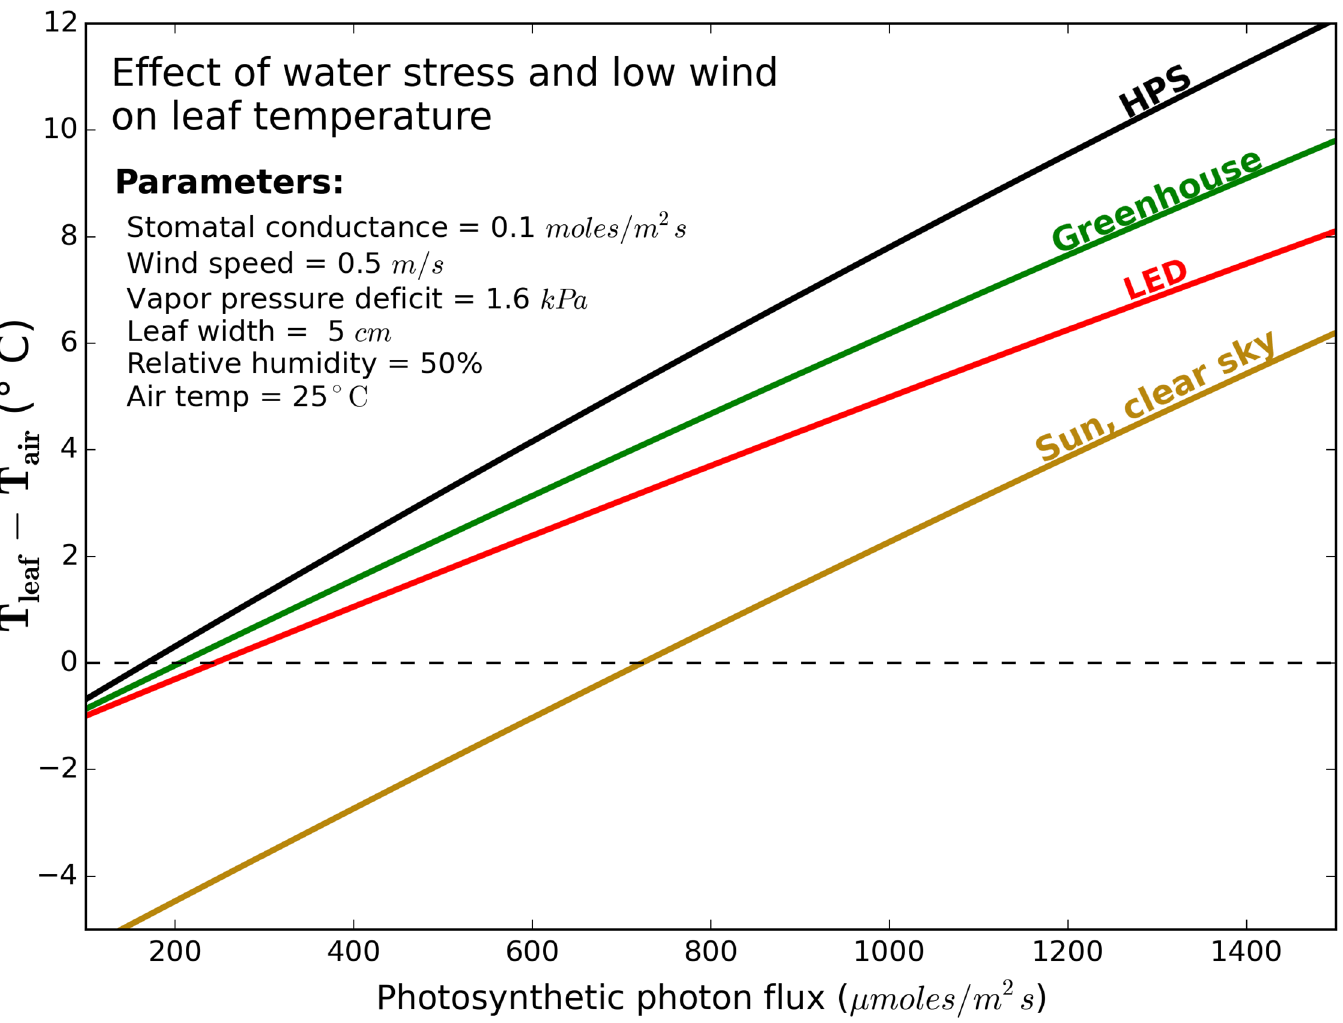
Fig 5. Calculated effects of PPF on the difference between leaf temperature and air temperature under four radiation scenarios in near worst-case conditions of water stress and low wind. Calculation is based on the average absoprtion of the four species measured. Differences among species was biologically